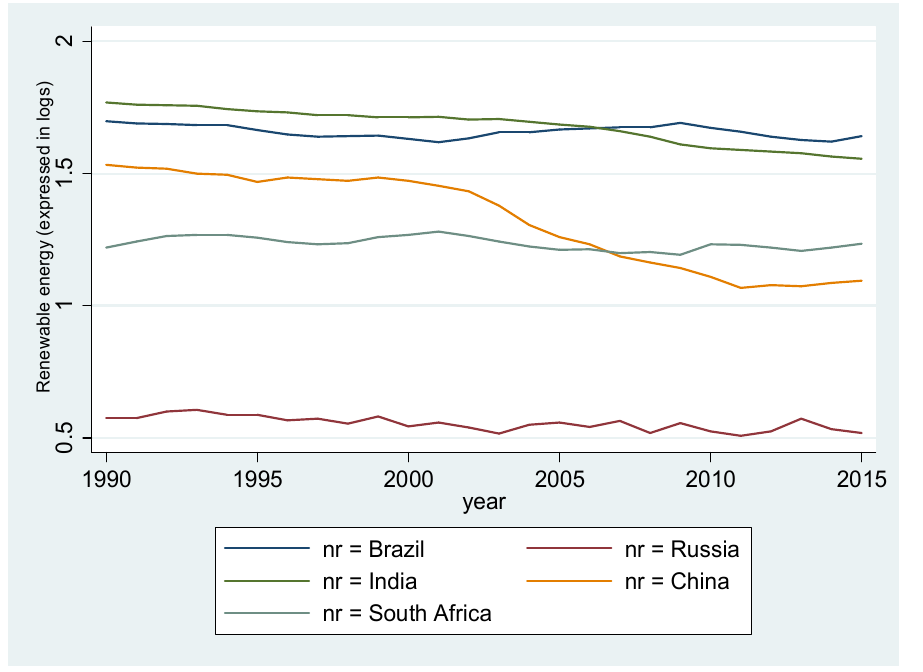
Figure 4. Panel data distribution of renewable energy. Source: Authors’ elaboration based on World Development Indicators (2021).